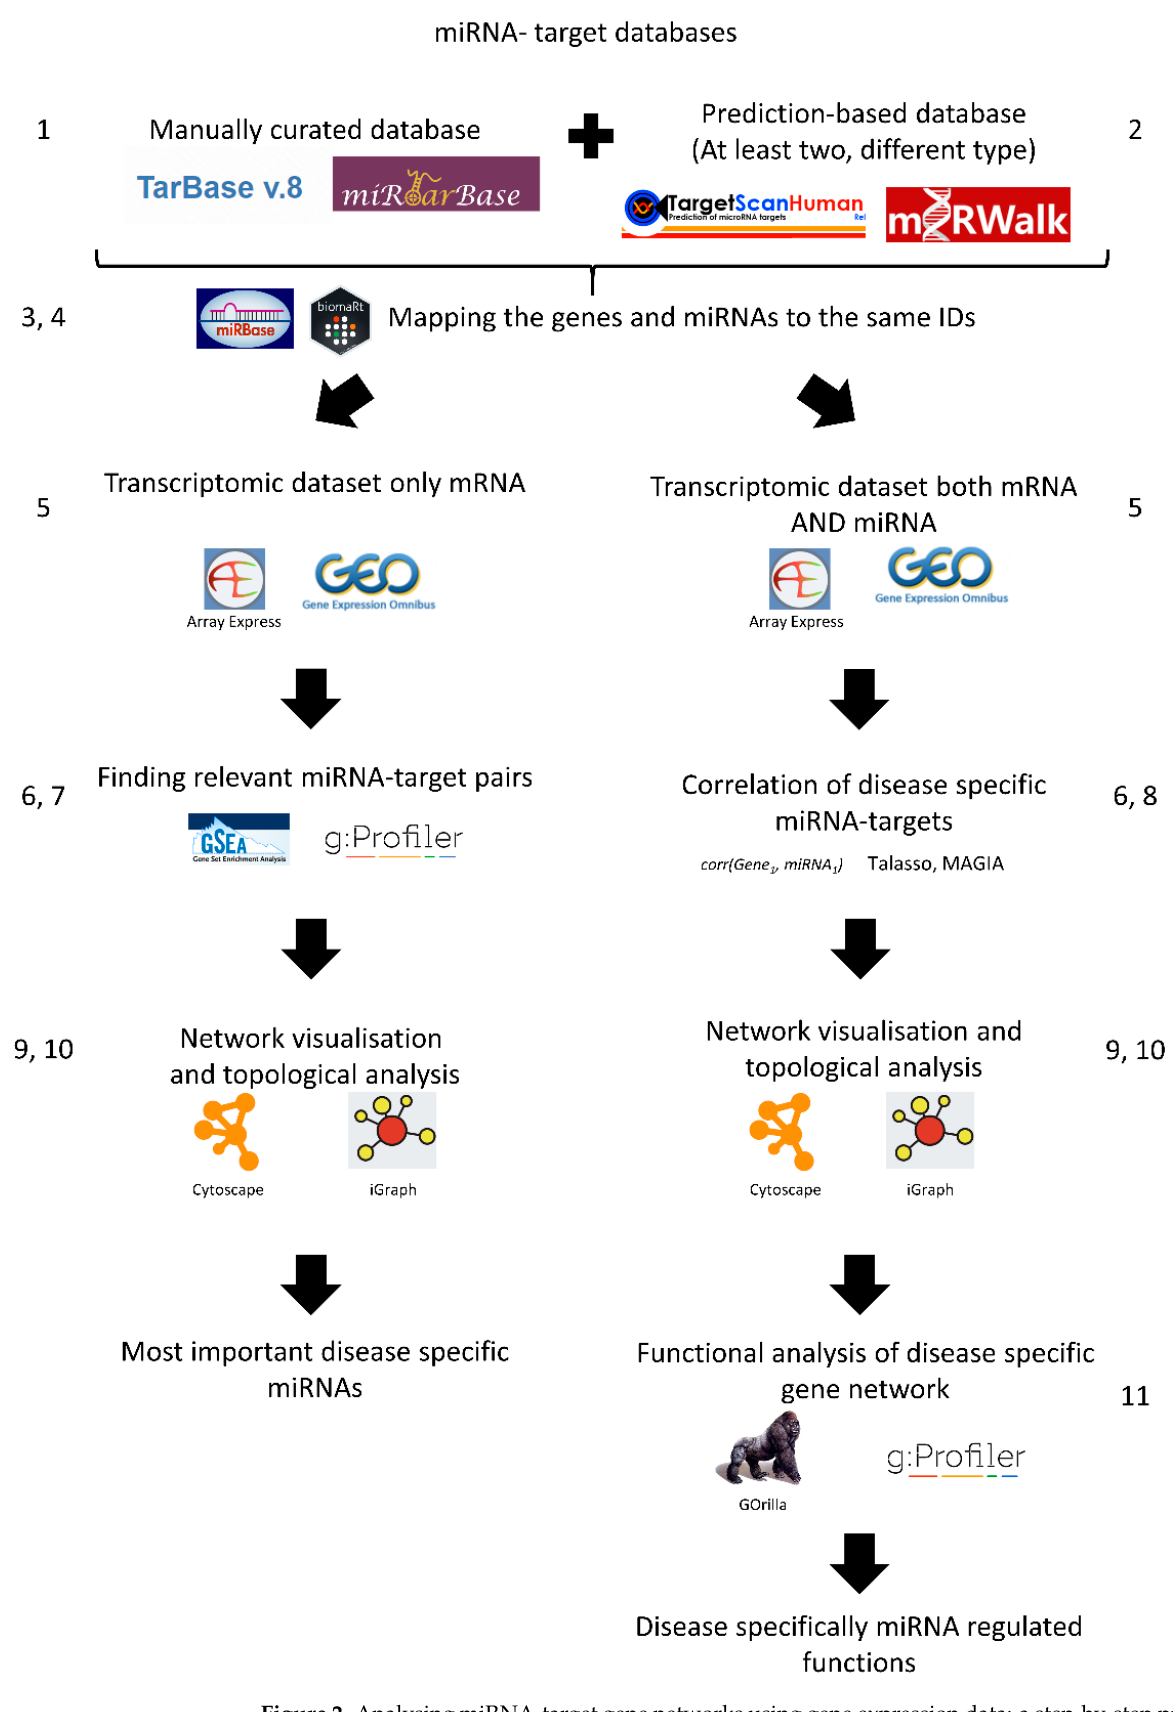
Figure 2. Analysing miRNA-target gene networks using gene expression data: a step-by-step pro- tocol.